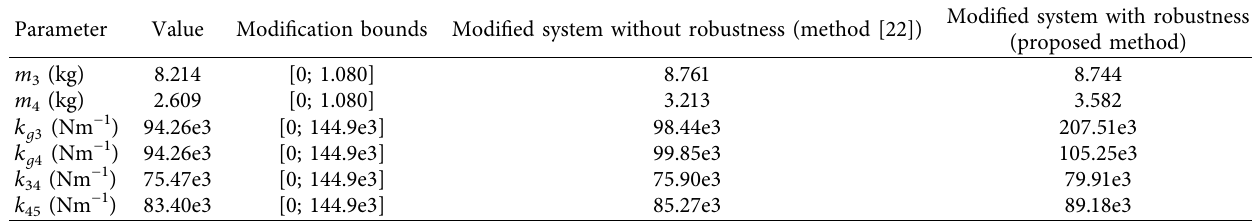
Table 6: Test-case 2: original and modified system design variables and constraints. Parameter